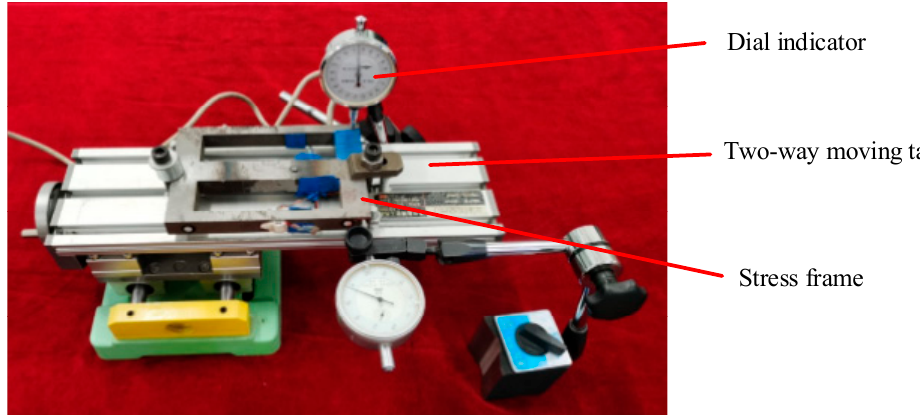
Figure 4. Measurements of levelness at the bottom of the stress